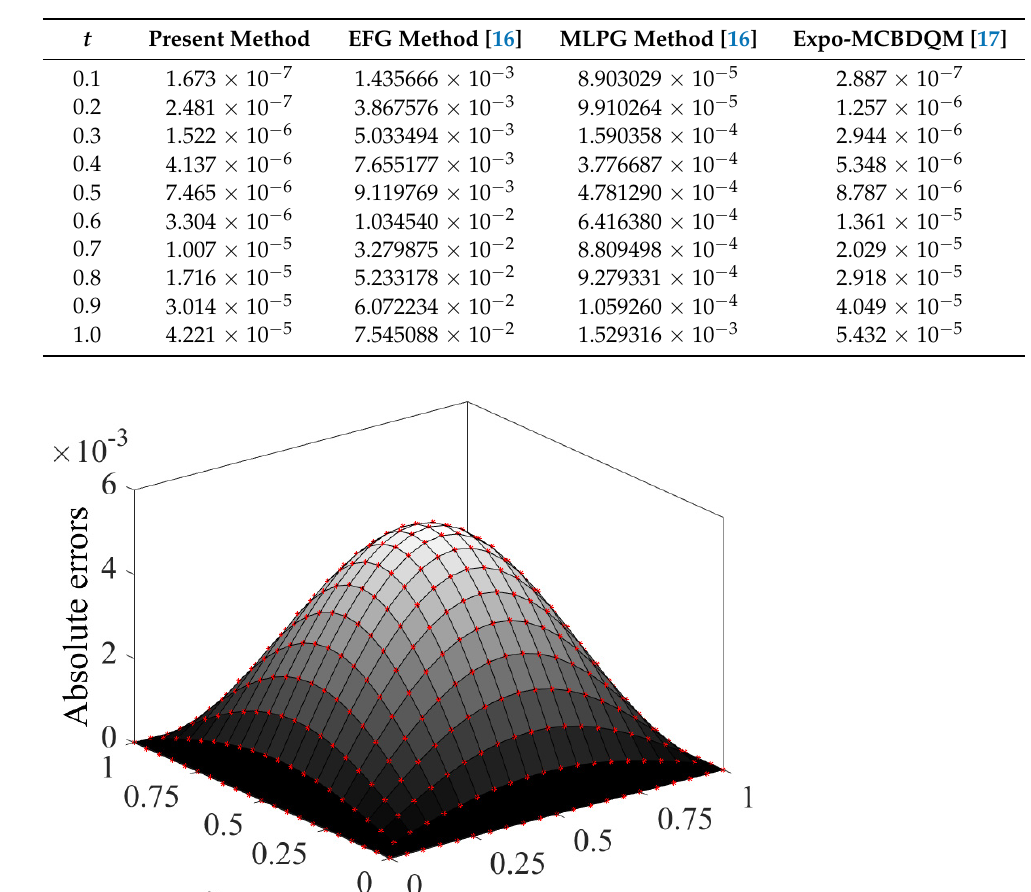
1 t = . Figure 7 shows the comparison of the analytical and numerical solutions. Figure 5. The analytical ( a ) and numerical ( b ) solutions with Figure 5. The analytical ( a ) and numerical ( b ) solutions with h = 0.05 and ∆ t = 0.01 for z = 1 at Table 4. Comparison between the present method and existing methods with 0.1 h = t = 1. at different values of t for Example 3. Table 3. Comparison between the present method and existing methods with h = 0.1 and 0.01 t Δ = Table 4. Comparison between the present method and existing methods with h = 0.1 and ∆ t = 0.01 at different values of t for Example 2. at different values of t for Example 3.